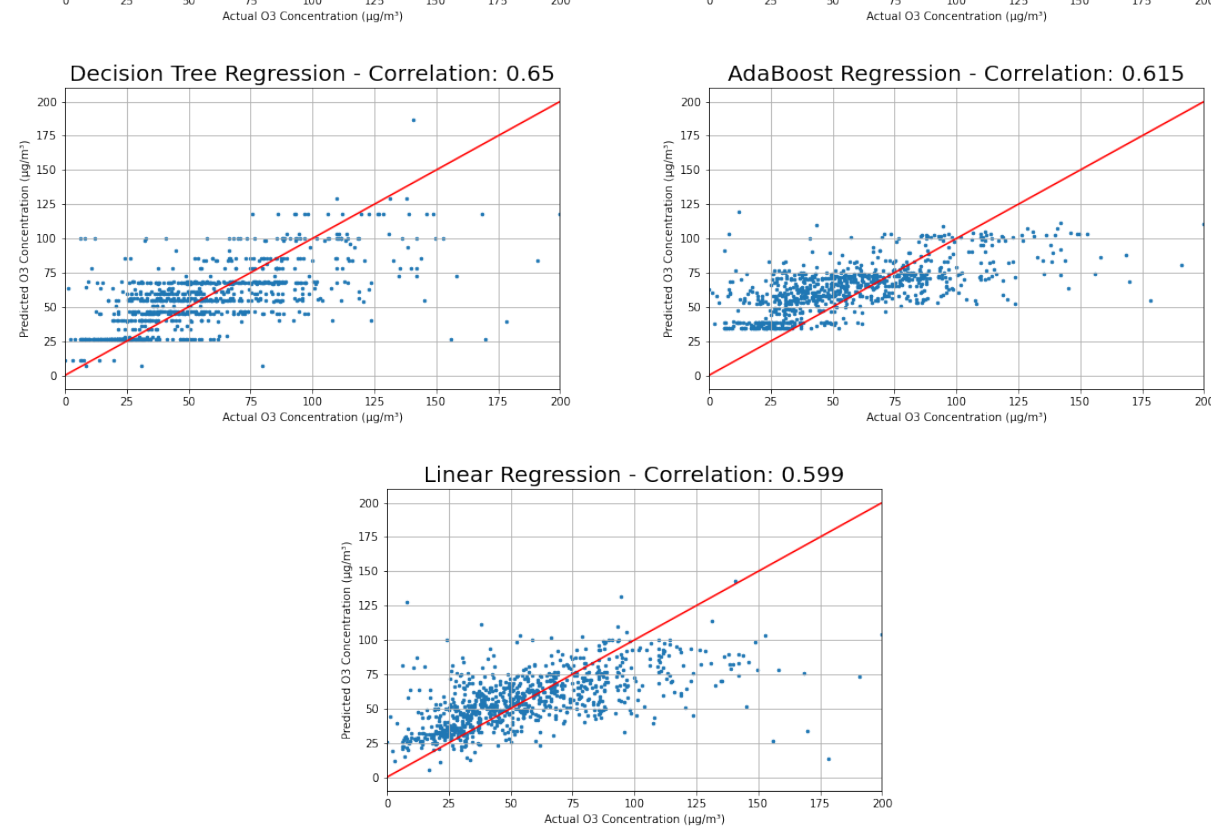
Figure 14. Actual versus predicted results of each model, with best-fit line and